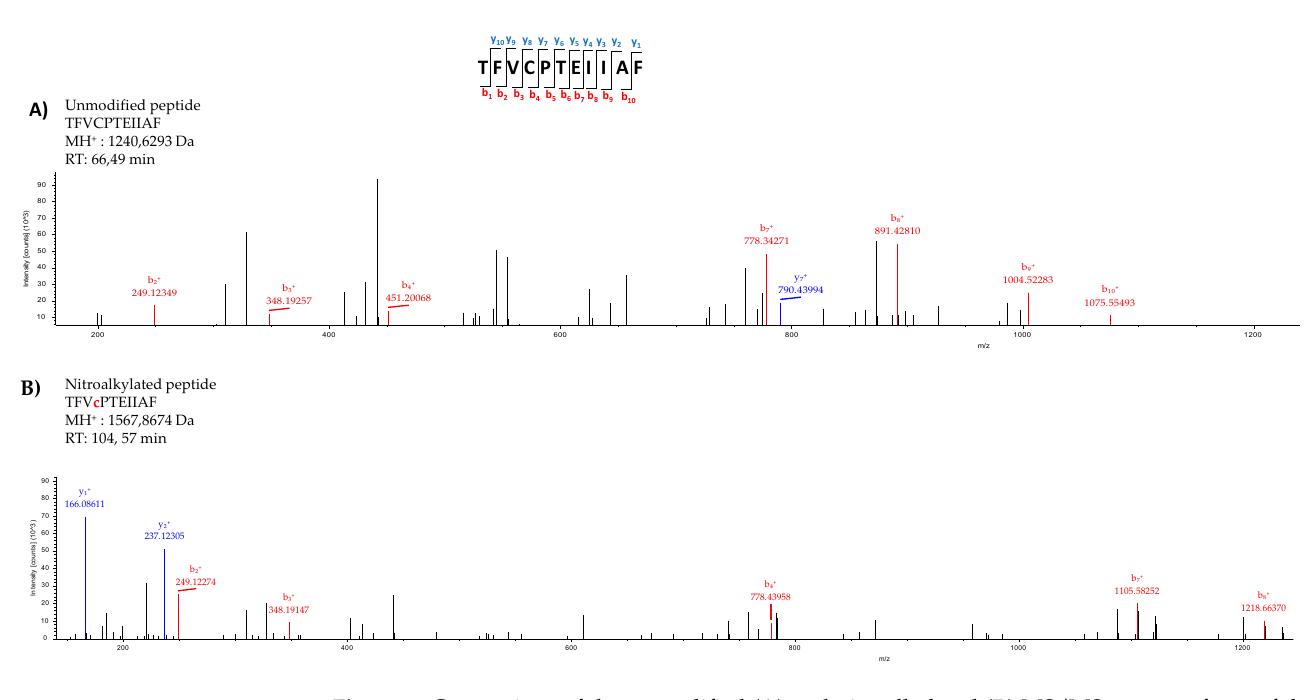
Table 1. Detection by nano-LC-MS/MS of the nitroalkylated peptides of the recombinant Tsa1 treated with NO 2 -OA and the identification of the target residues after the adduction with NO 2 -OA. The position of the nitroalkylation target is highlighted in lowercase. Cys: cysteine; His: histidine. Recombinant Tsa1 Nitroalkylated Peptides